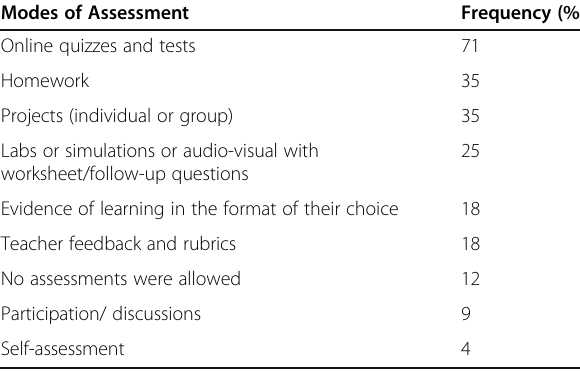
Table 2 Teachers ’ assessment strategies in an ERT